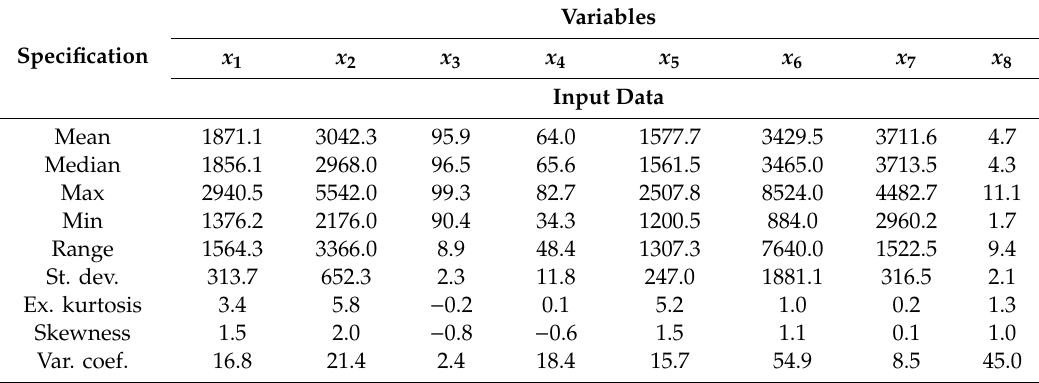
Table 3. Descriptive statistics of the variables of LAUs at the regional level.